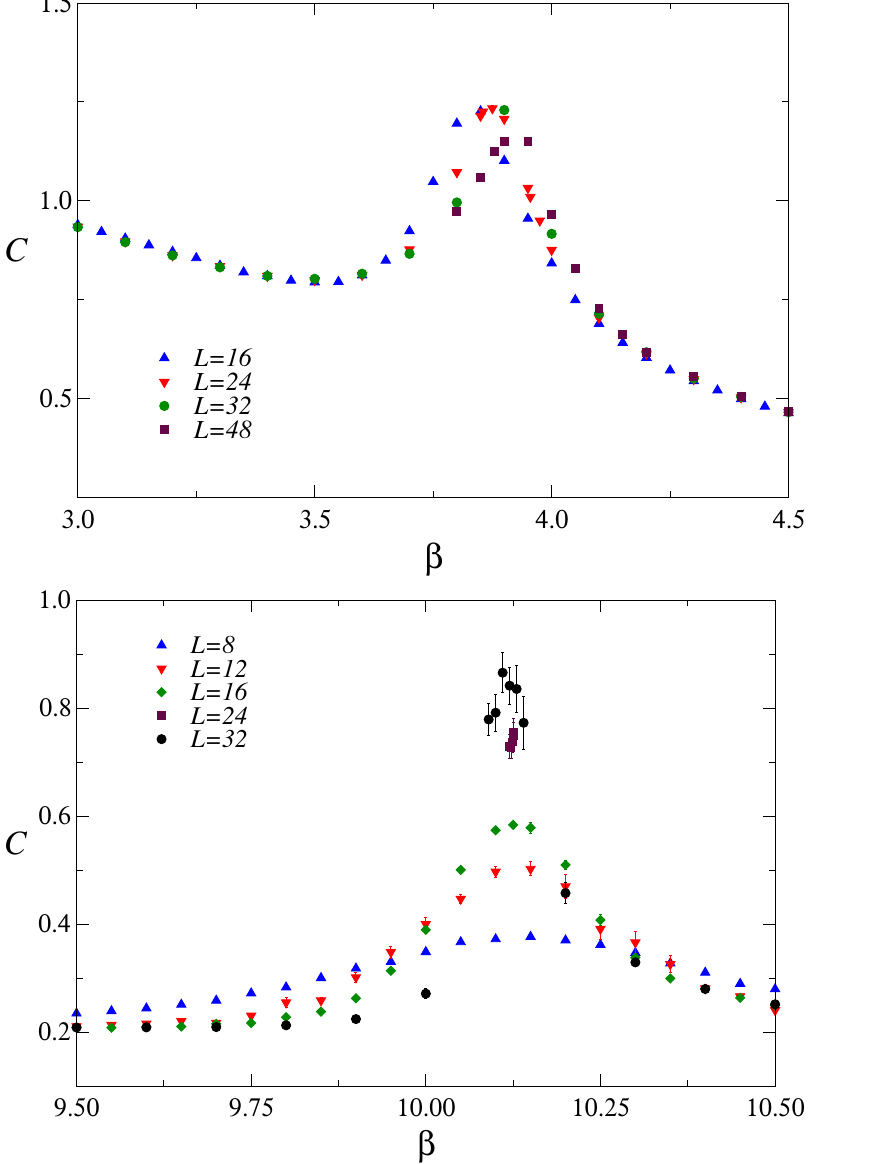
Figure 7 . Plot of the specific heat C versus β for N c = 2 , N f = 4 (top) and N c = 3 , N f = 3 (bottom). In both cases γ = 0 and v = 1